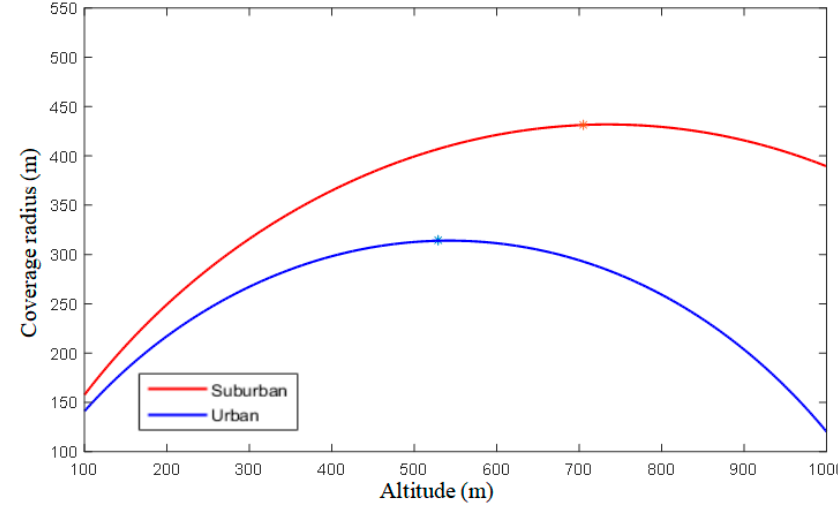
Figure 2. The relationship of the altitude and the coverage radius for a DBS.